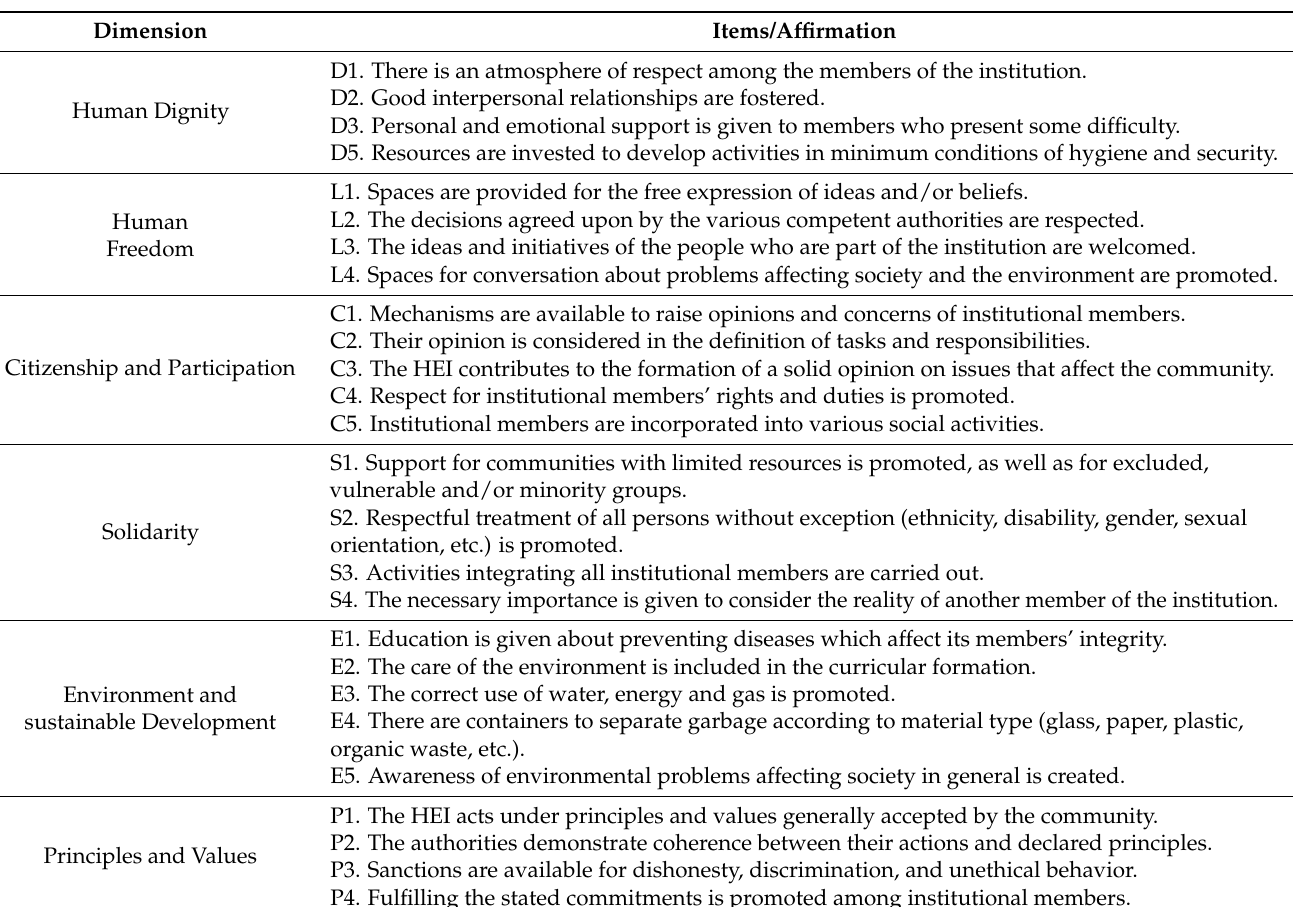
Table 1. Questionnaire on HEI (Higher Education Institution) social responsibility